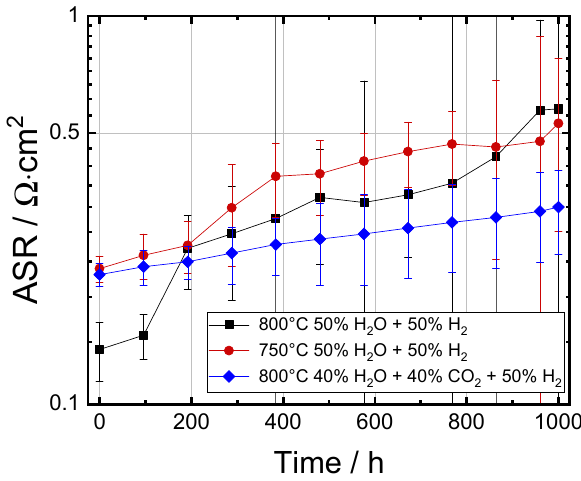
Figure 3. Evolution of ASR during long-term electrolysis measurements.